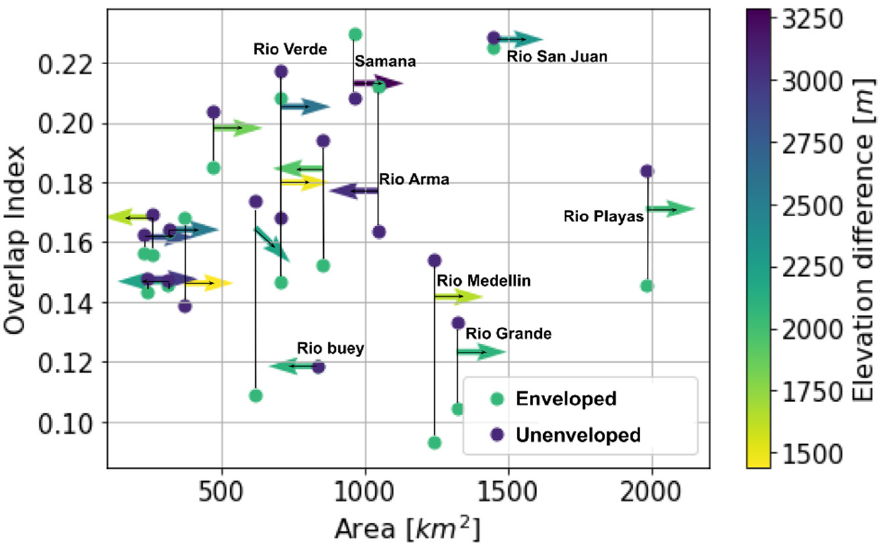
Figure 11. Overlap index in function of the area, aspect, and elevation gradient of the watersheds. The arrows correspond to the analyzed watershed denoting its main aspect. The arrows represent the watershed aspect, and the color corresponds to the elevation gradient ( H max – H min ). The purple and green circles represent the overlap index, I oc , for the enveloped and unenveloped systems.